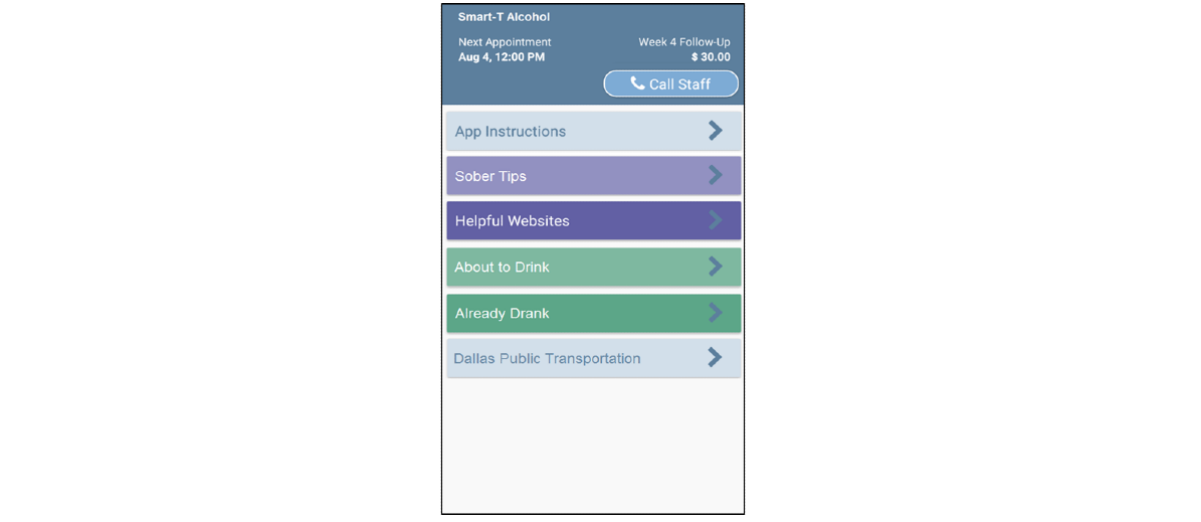
Figure 4. Anticipated Smart-T alcohol phase III home